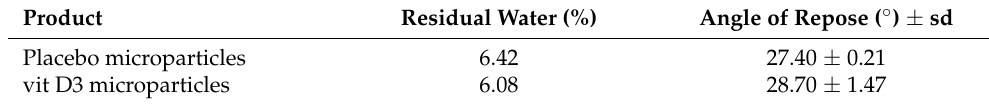
Table 5. Percentages of residual water in dried microparticles and flowability